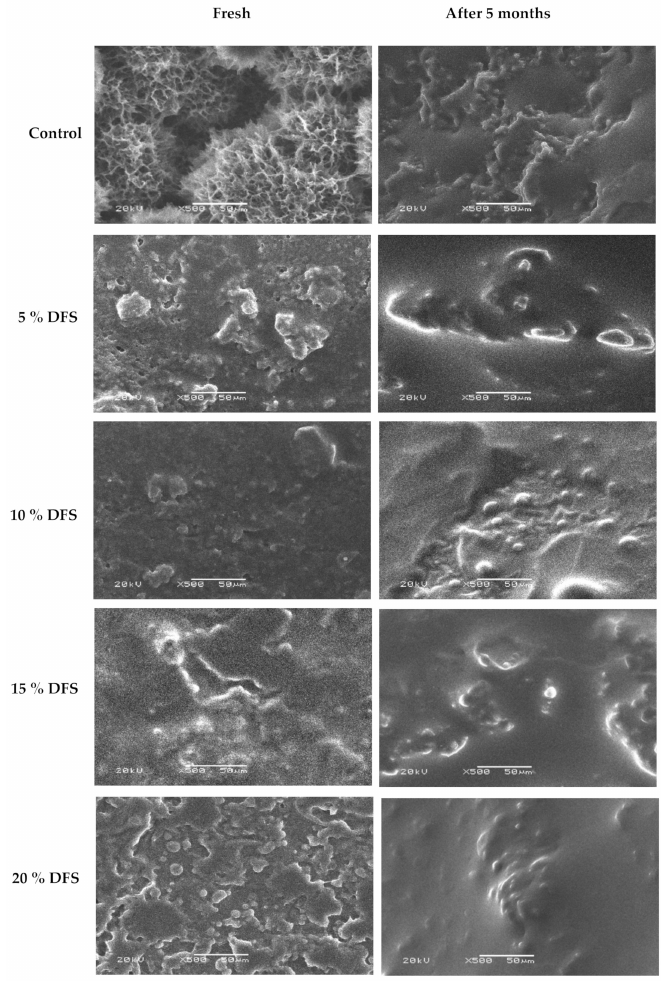
Figure 5. Scanning electron micrographs of the effect of DFS on the overall structure of block-type processed cheese when fresh and after five months of storage at room temperature. Magnitude 500 × ; 20 kV. Bar = 50 µ